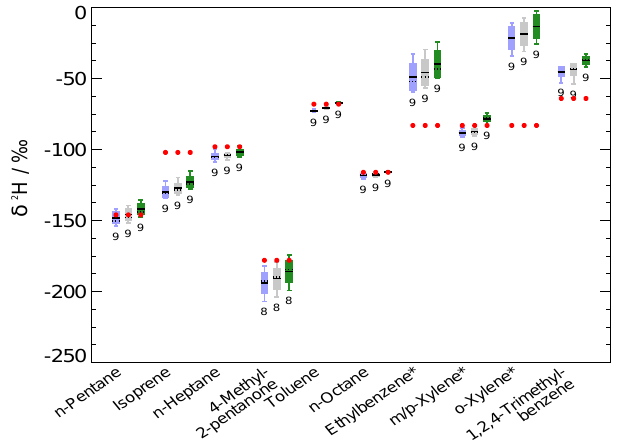
Figure 8. The same measurement series was analysed 3 times us- ing H + factors of 5.0 (grey boxes), 5.3 (blue boxes) and 5.8 (green 3 boxes). For comparison the results of EA (Agroisolab) are presented as red dots. The whisker plot is as in Fig. 3 (*not comparable to the results of Agroisolab); see text for more